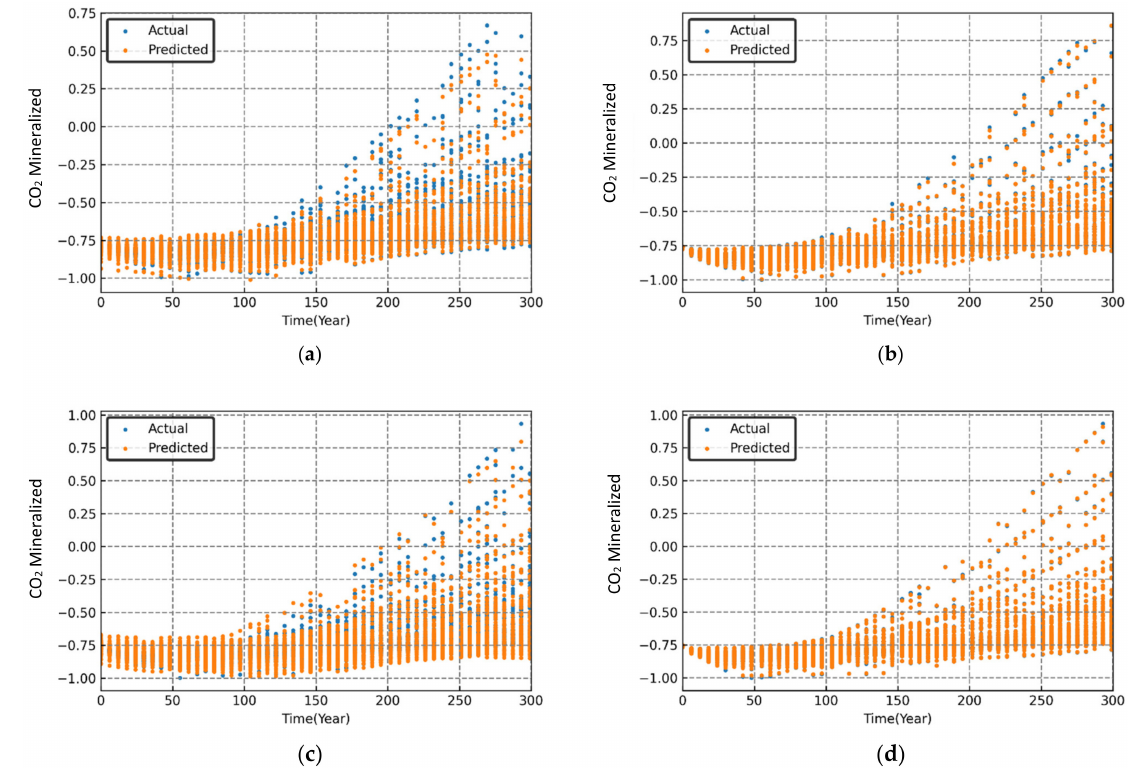
Figure 11. Variation in simulated and predicted mineralized CO 2 (normalized) over time for different sets of randomized input parameters. ( a ) MLP; ( b ) RF; ( c ) SVR; ( d )